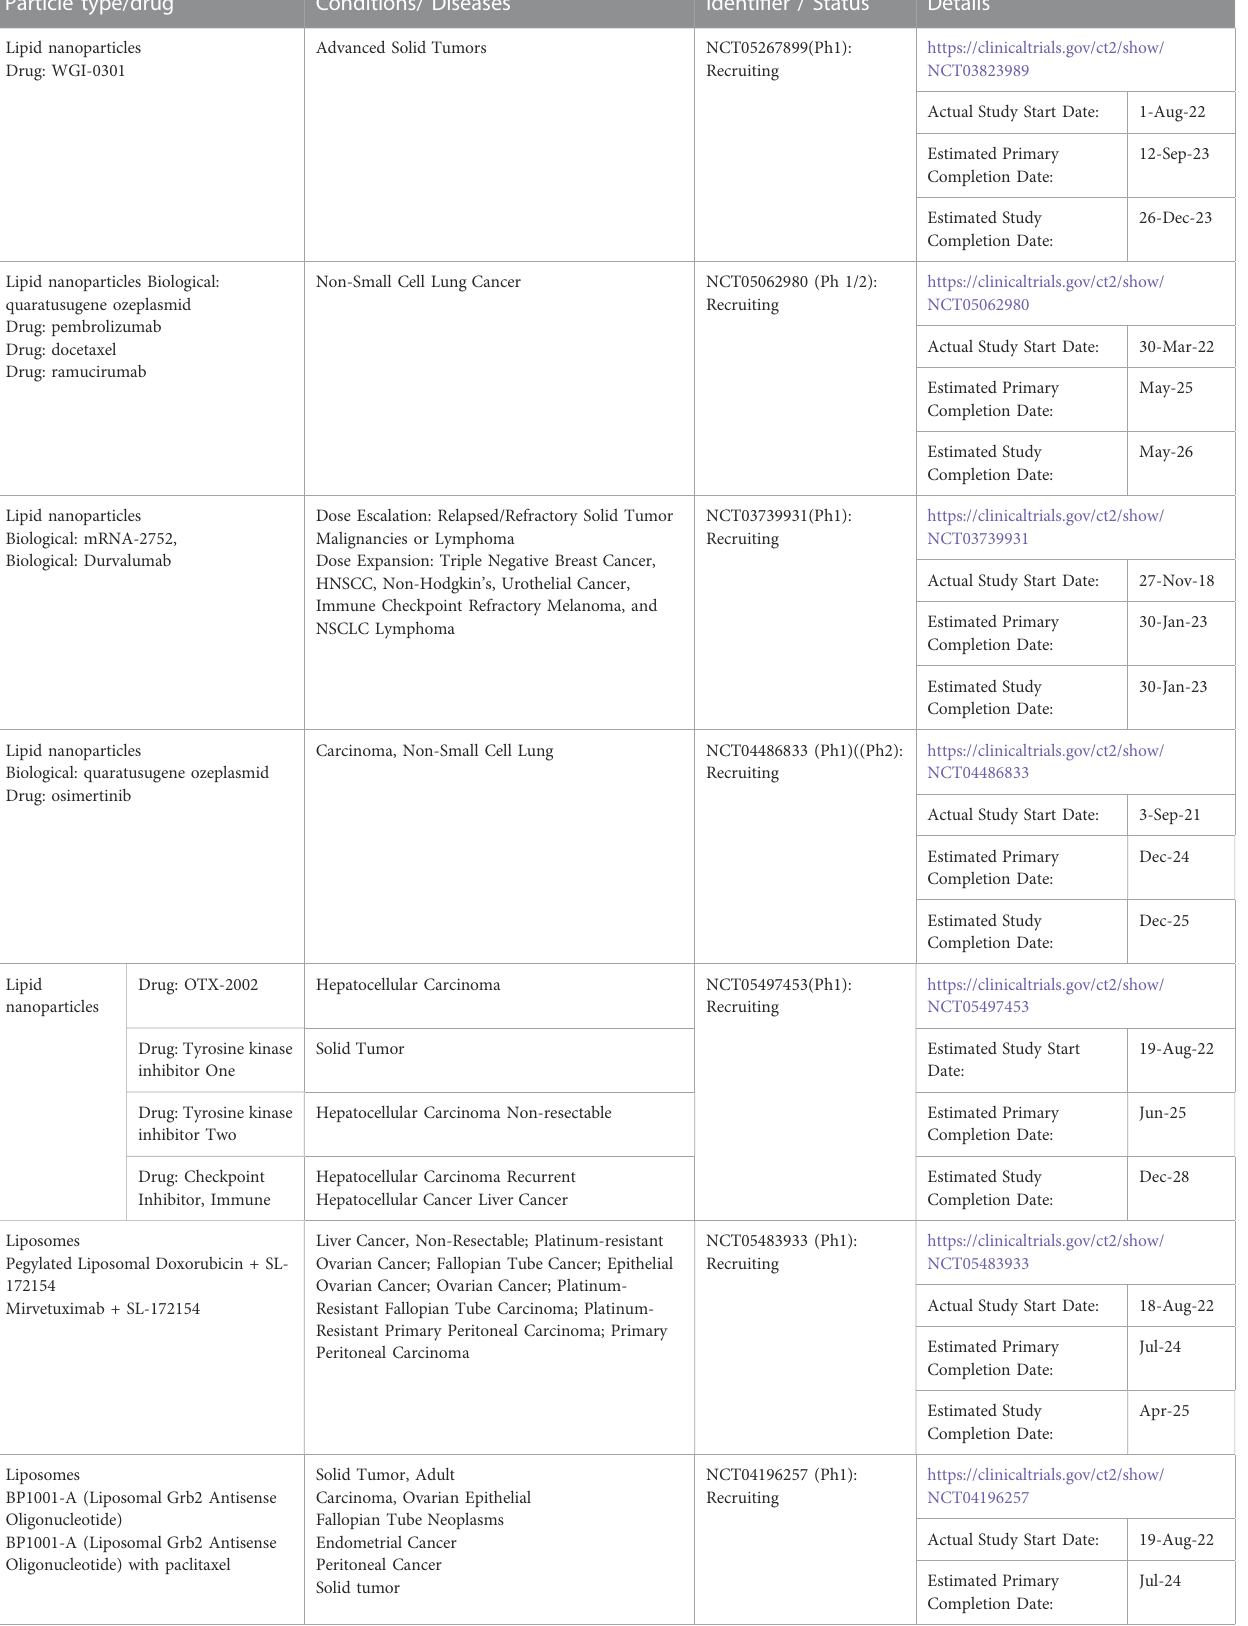
TABLE 4 Some examples of clinical trials involving lipid-based nanoformulations for cancer